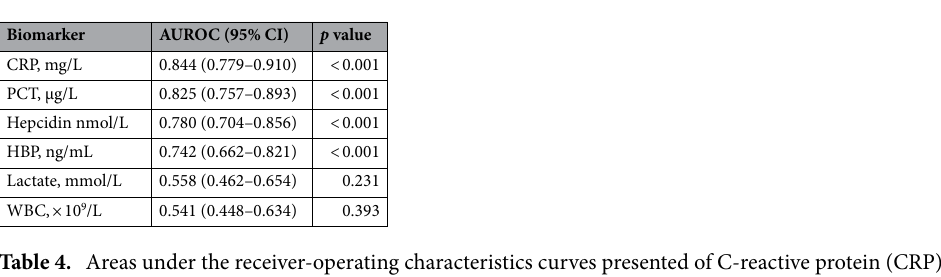
Table 4. Areas under the receiver-operating characteristics curves presented of C-reactive protein (CRP), procalcitonin, hepcidin, heparin-binding protein (HBP), lactate and white blood cell